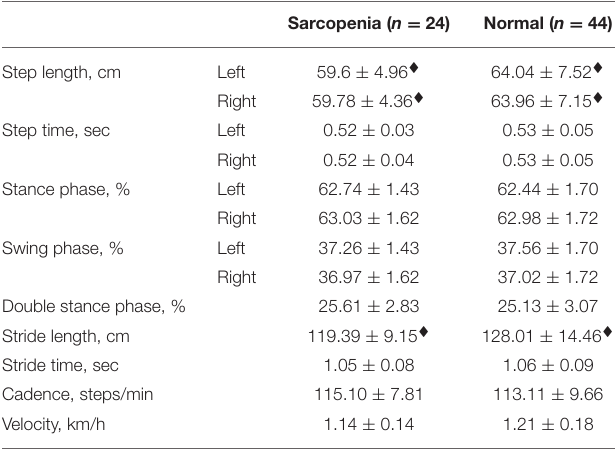
TABLE 2 | Basic gait parameters of the participants.